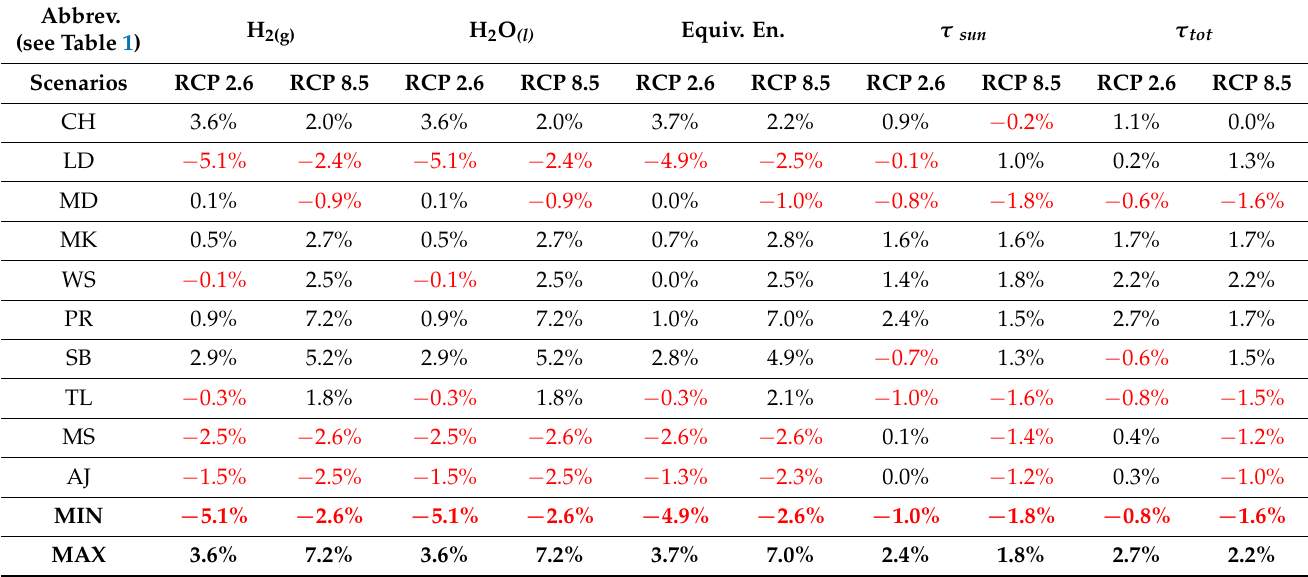
Table 5. Past evolution (historical data, 2005) to actual situation (RCPs data, 2020). For year 2020, both extreme scenarios RCP 2.6 and RCP 8.5 are simulated. Red numbers correspond to a negative balance of the studied quantity in the period